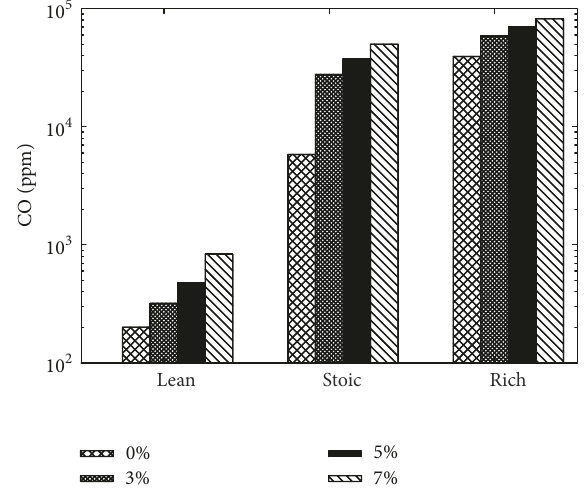
Figure 10: Effect of RGF and equivalence ratio on engine-out CO